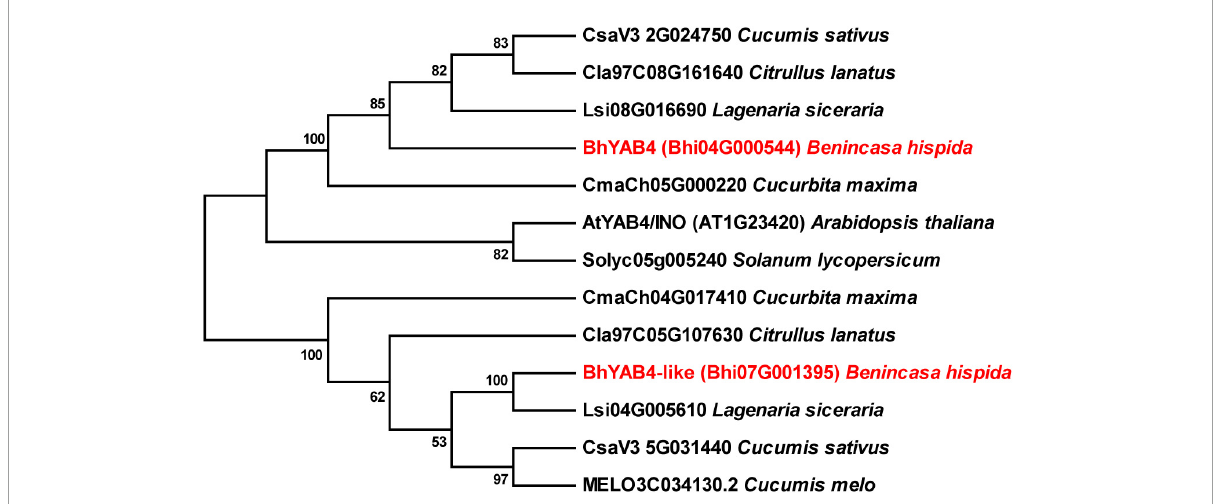
FIGURE5 Phylogenetic analysis of BhYAB4 and its homologous proteins. The phylogenetic tree was constructed using YAB4 proteins from the wax gourd, Arabidopsis , tomato, and other cucurbits. Wax gourd YAB4 proteins are presented in red.